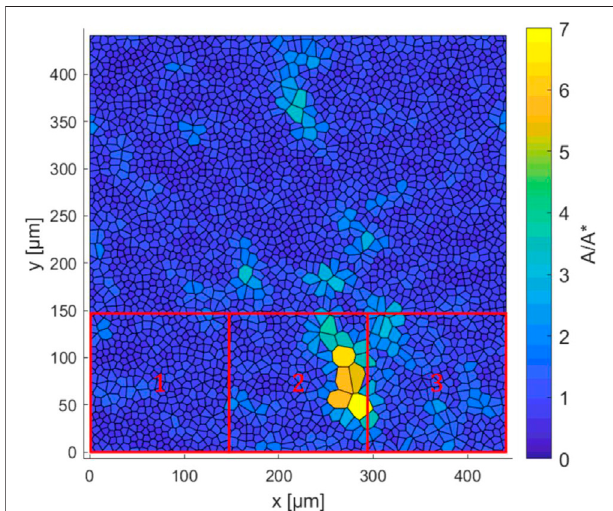
FIGURE3| Voronoi-polygonareasofthemicrographof Figure1 .Three detailsarehighlightedforvisualizationofdetailsinfollowingFigures;thesizeof the details is equal to the SVEs and MVEs